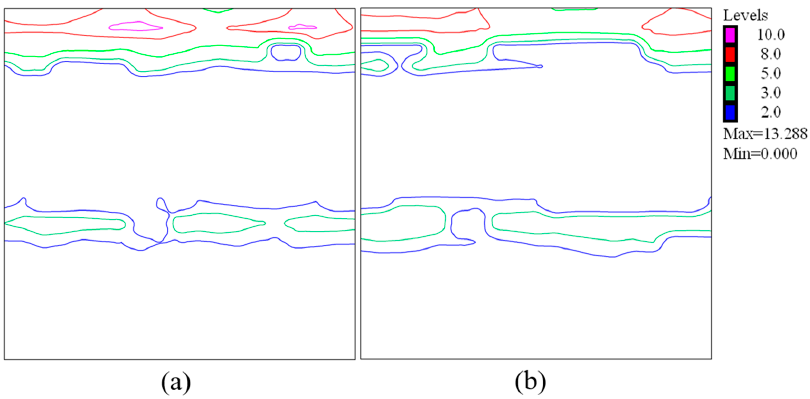
Figure 12. The ODF sections ( φ 2 = 45°) of 70% clock-rolled Ta plates along the thickness after annealing at 1250 °C for 10 min: ( a ) Surface layer, ( b ) center layer.